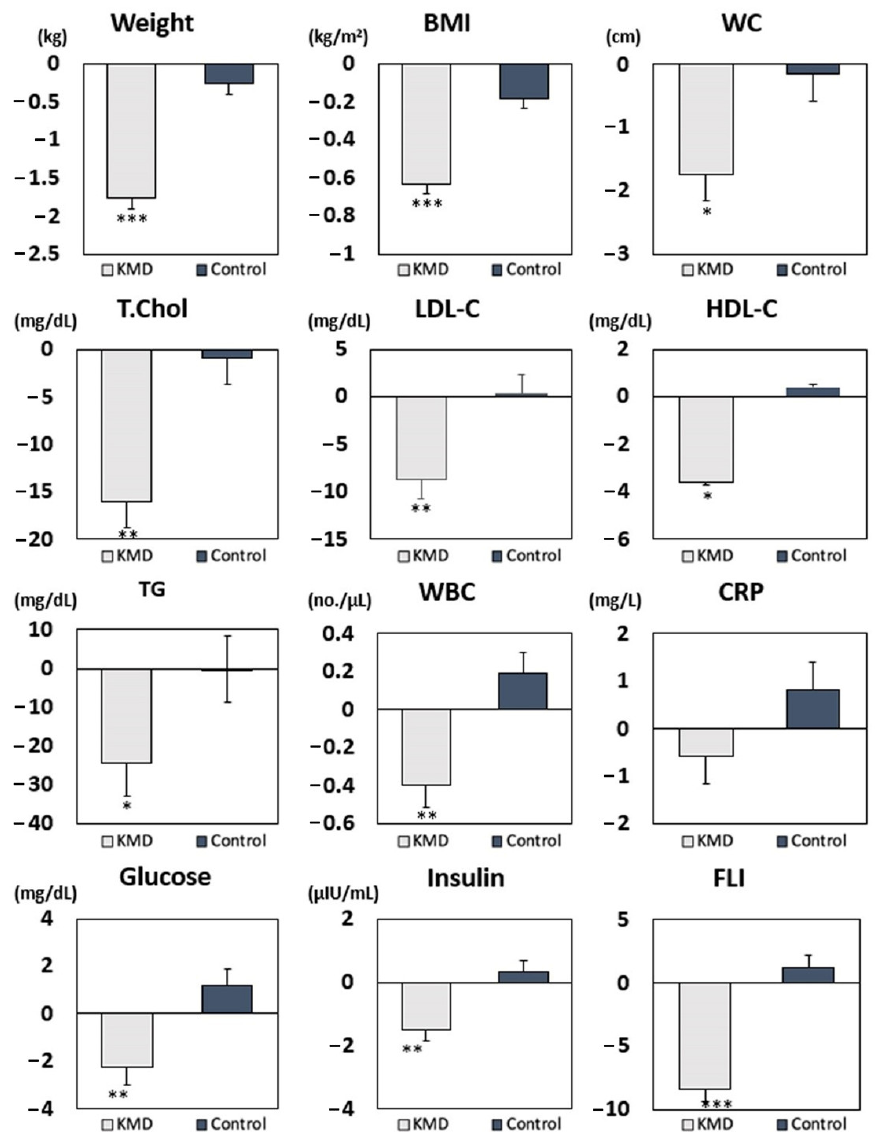
Figure 4. Mean changes in anthropometric and cardiometabolic parameters according to the KMD and control diet. Abbreviations: KMD, Korean style Mediterranean diet; BMI, body mass index; WC, waist circumference; T.chol, total cholesterol; LDL-C, low-density lipoprotein cholesterol; HDL-C, high-density lipoprotein cholesterol TG, triglycerides; WBC, white blood cell; CRP, C-reactive protein; FLI, fatty liver index. * p -value < 0.05, ** p -value < 0.005, *** p -value < 0.0001.